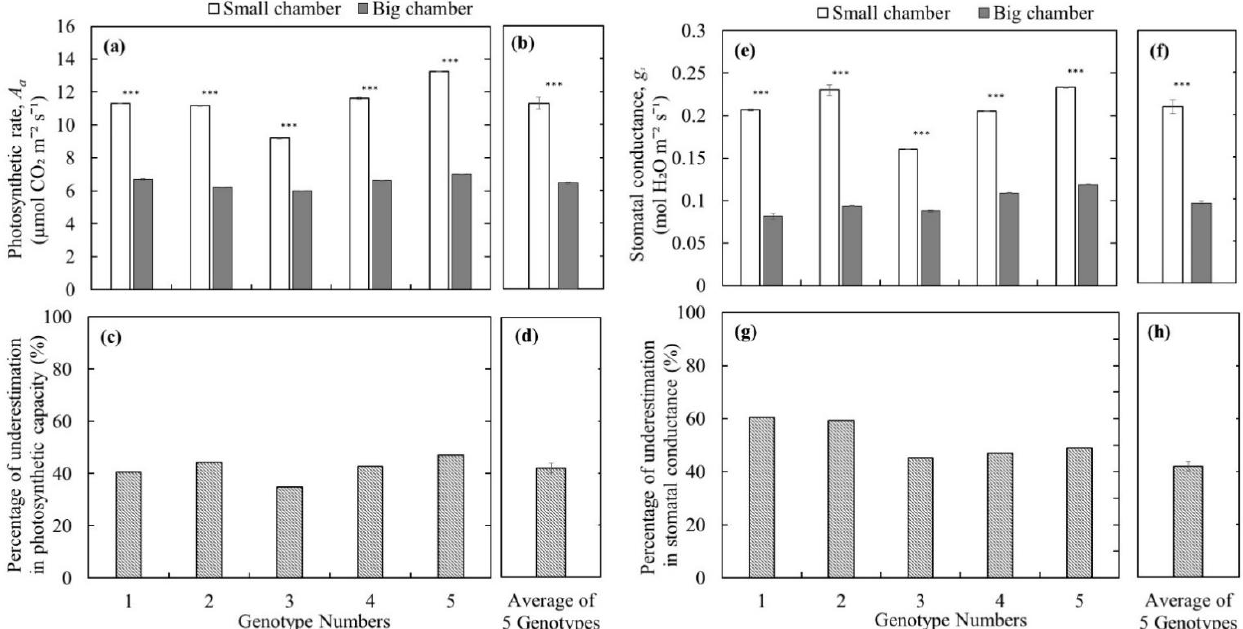
Figure 3. Comparison of leaf photosynthetic rate in ( a , b ); Underestimation of leaf photosynthetic capacity in ( c , d ); Leaf stomatal conductance in ( e , f ); and Underestimation of leaf stomatal conductance in ( g , h ) between small leaf chamber and big leaf chamber of Li-Cor under 1000 PAR from five different genotypes of wild blueberry plants ( Vaccinium angustifolium ) (bars in figures ( a , e ) are means ± SEs of different measurements for the same leaf groups enclosed in the big chamber or single leaf in the small chamber; bars in figures ( b , d , f,h ) are means ± SEs of the studied five different genotypes; p < 0.05 *, p < 0.01 **, p < 0.001 ***).